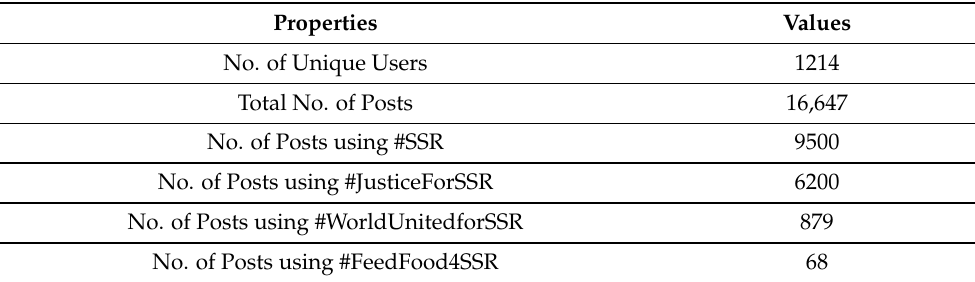
Table 1. Statistics of data collected from